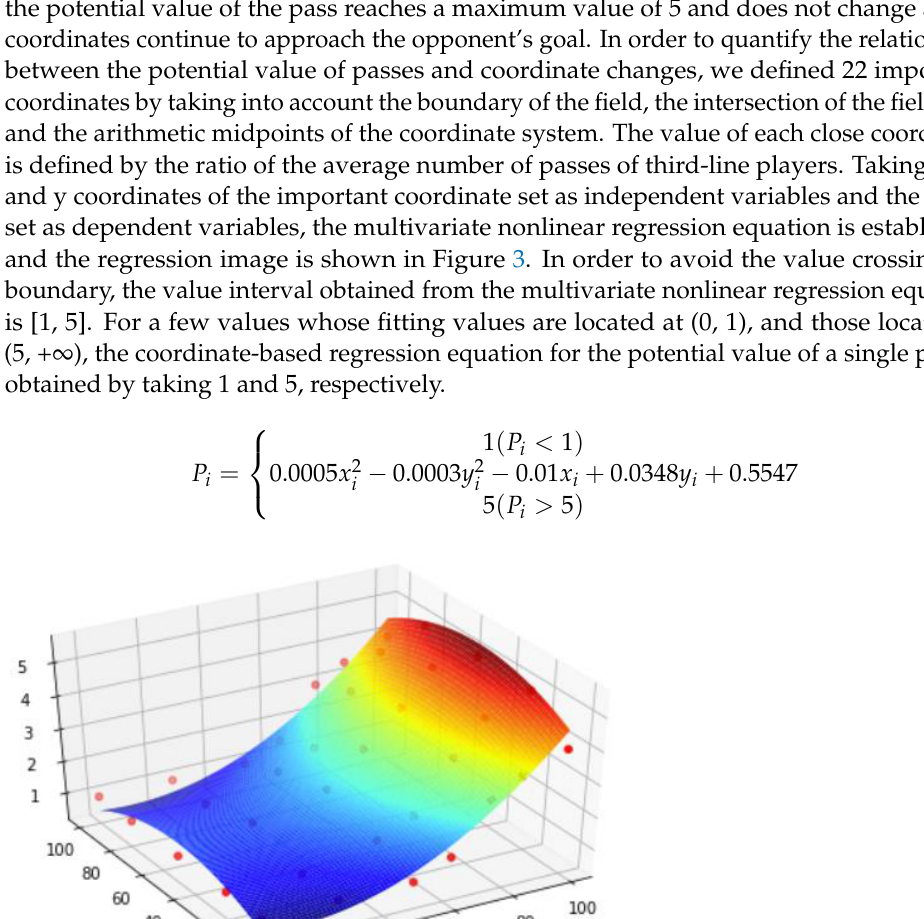
Figure 2. Field zoning plan.